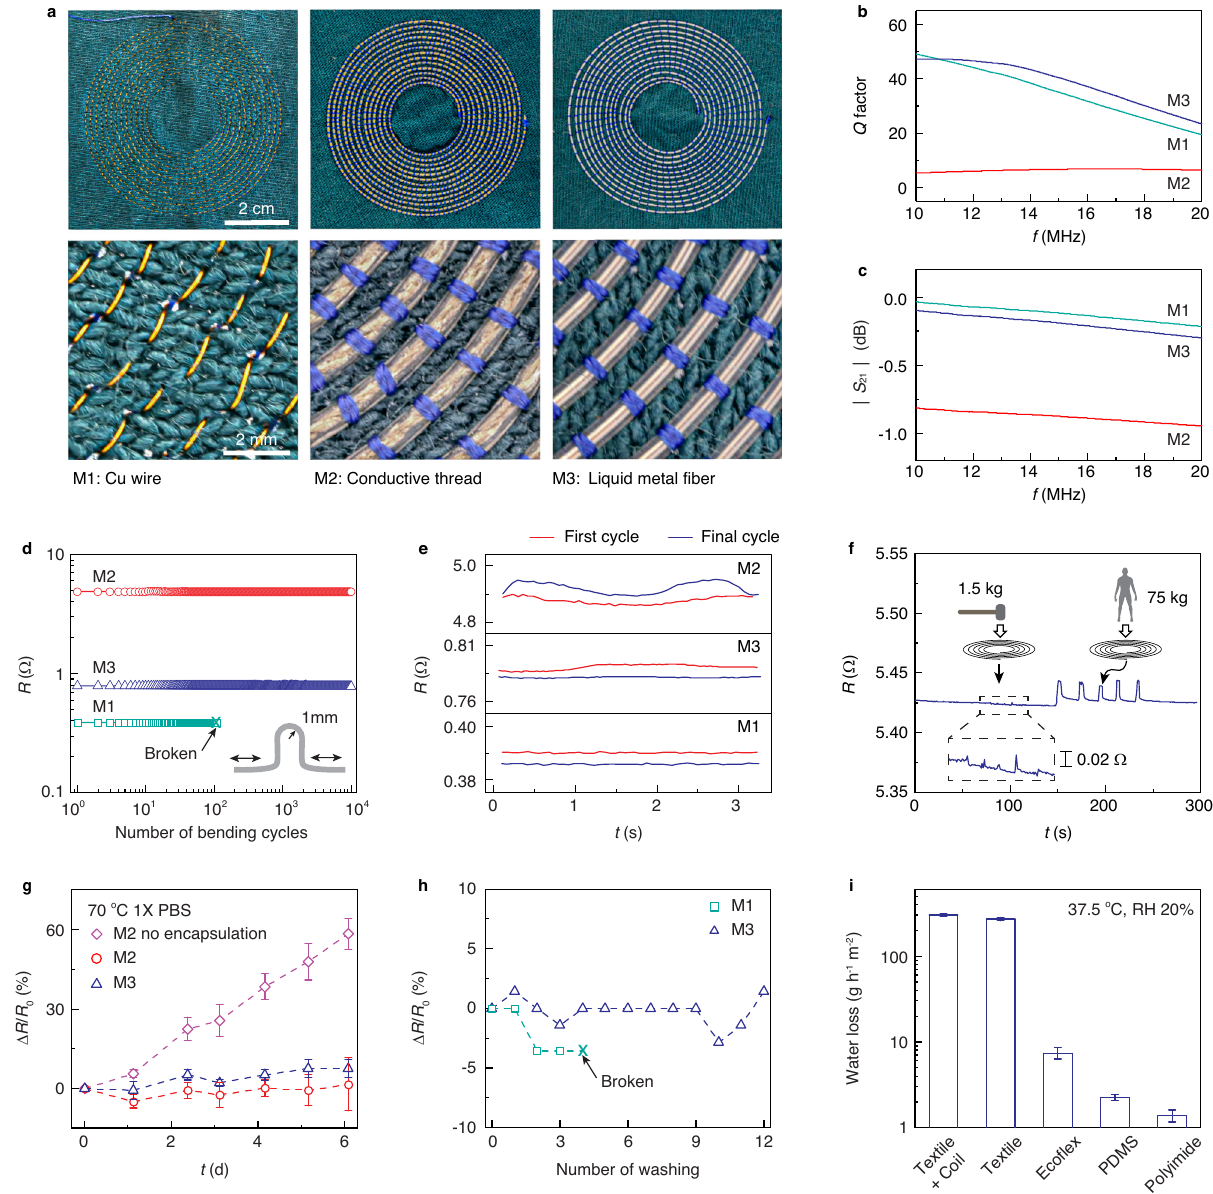
Fig. 2 Electromagnetic and mechanical characterization. a Images of spiral inductors fabricated by embroidering copper wire (M1), conductive thread encapsulated with polyurethane (M2), and liquid metal fi ber (M3). b Measured quality factor Q from embroidered spiral inductors. c Measured scattering parameter ∣ S 21 ∣ from embroidered 10-cm length transmission lines. d – f Resistance of the spiral inductors as a function of number of bending cycles ( d ), during the fi rst and fi nal bending cycle ( e ), and when compressed by the weight of a hammer or human adult ( f ). g , h Relative change in resistance when the spiral inductor is immersed in 70 °C 1× PBS ( g ) and subjected to cycles of machine washing ( h ). i Water loss through the spiral inductor, textile substrate, and conventional fl exible substrates (Eco fl ex, PDMS, and polyimide) at 37.5 °C and 20% relative humidity. Error bars show mean ± s.d. Source data are provided as a Source Data fi